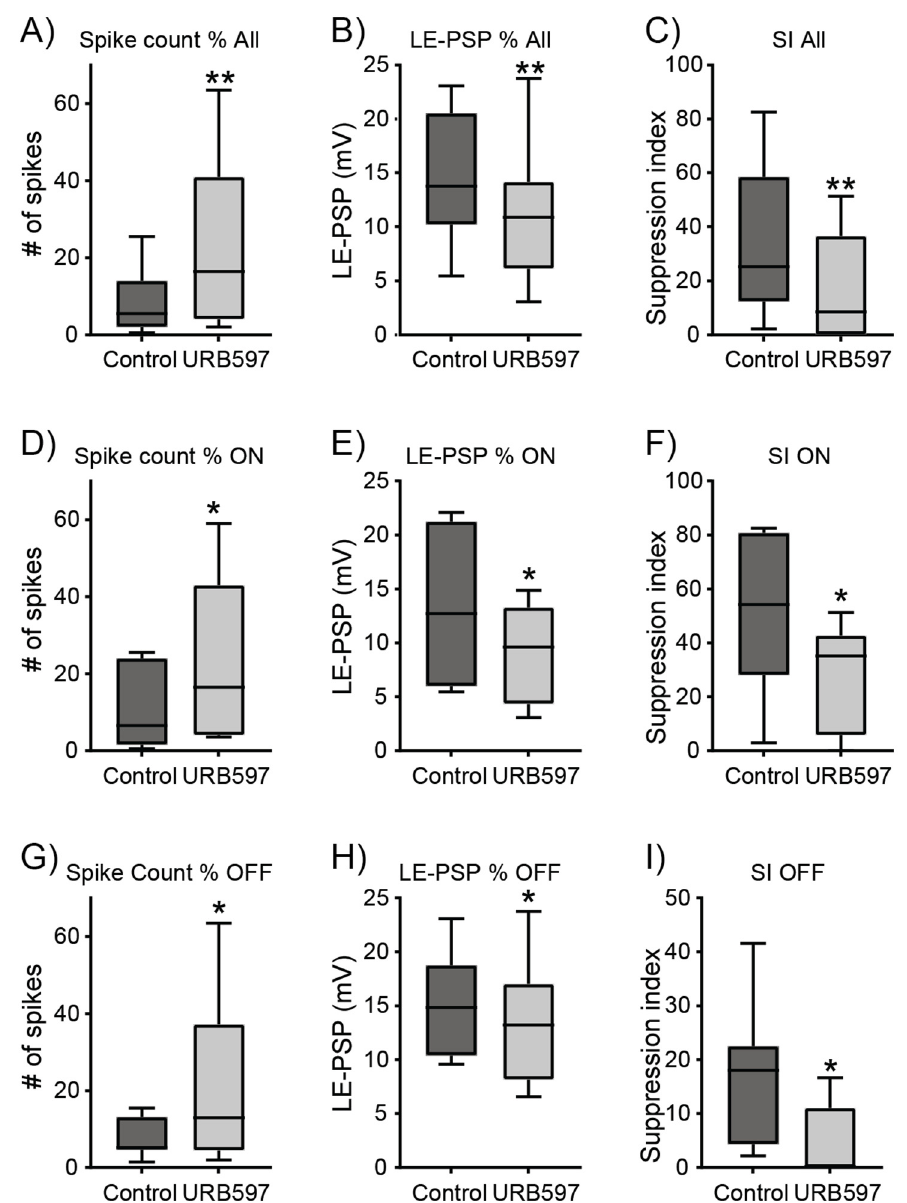
light-evoked response and suppression index in both cell types (Figure 2E,F,H,I; p < 0.05, n = 7 ON cells and 8 OFF cells).